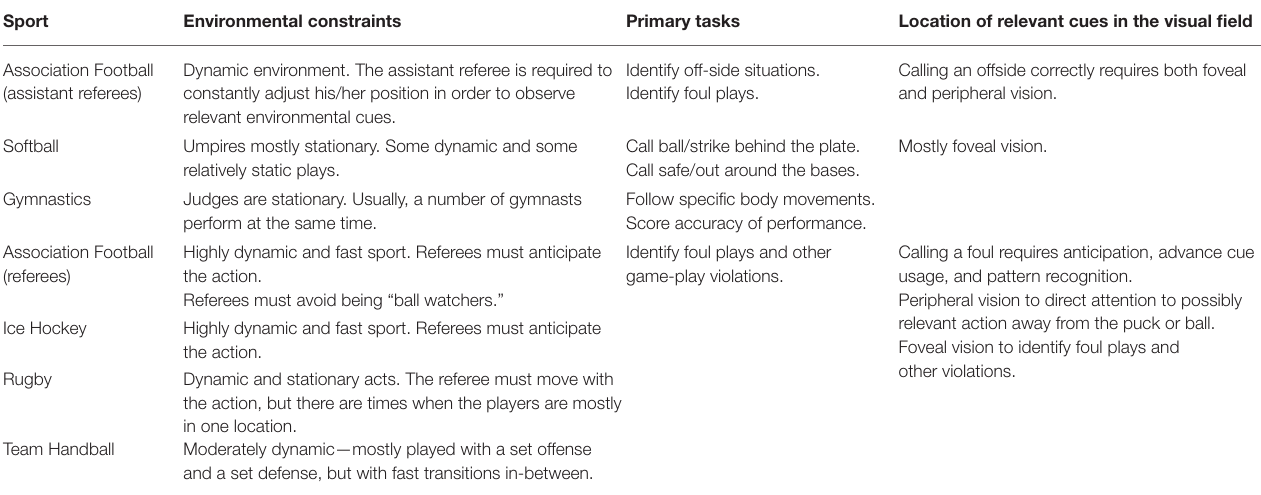
TABLE 1 | A description of environmental constraints, referees’ tasks, and location of relevant cues in the visual field across the sports reviewed.